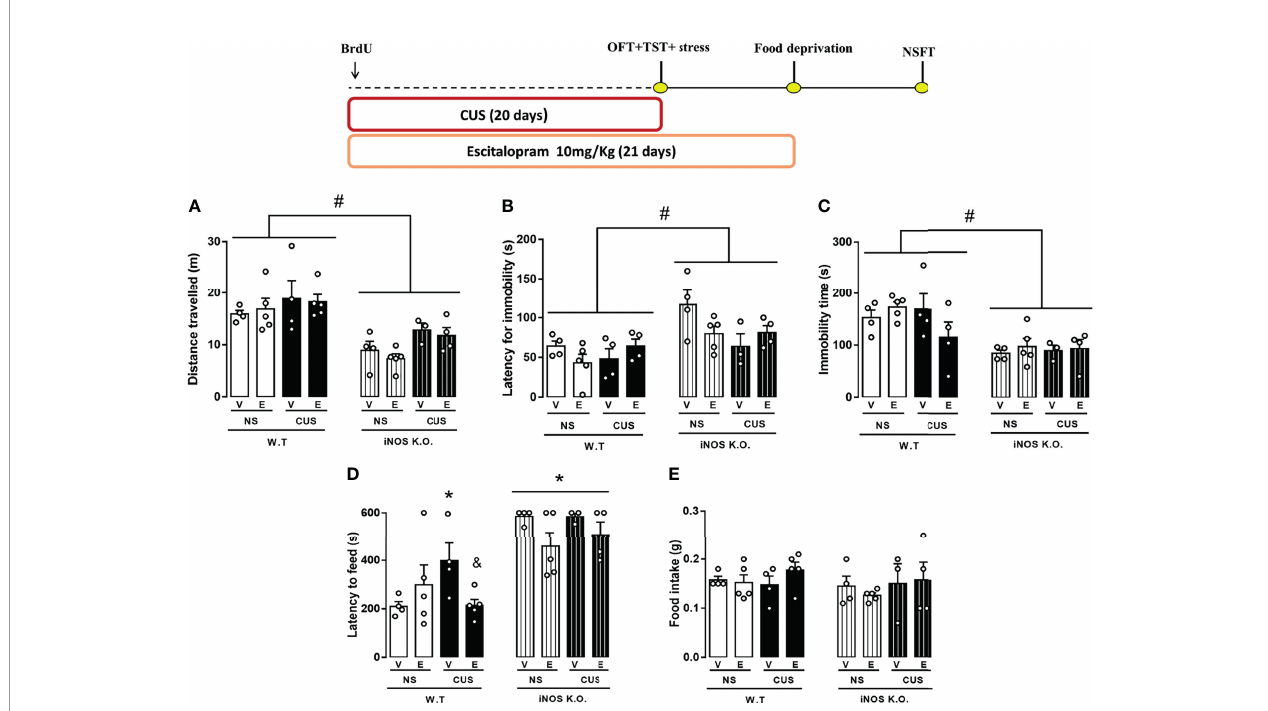
FIGURE 6 | Escitalopram is devoid of behavioral effects on iNOS KO mice. (A) total distance travelled on the open fi eld test (n=4,5,4,5,4,5,3 and 4 respectively); (B) fi rst immobility episode and (C) total immobility time on the tail suspension test (n=4,5,4,4,4,4,3 and 4 respectively); (D) latency to feed in a novel environment (E) total feeding consumption during fi ve minutes in home-cage (n=4,5,4,5,4,5,3 and 4 respectively). Data presented as mean ± S.E.M. *p < 0,05 from WT non- stressed vehicle; # indicates p < 0.05 on genotype factor; & p < 0.05 compared with WT CUS vehicle